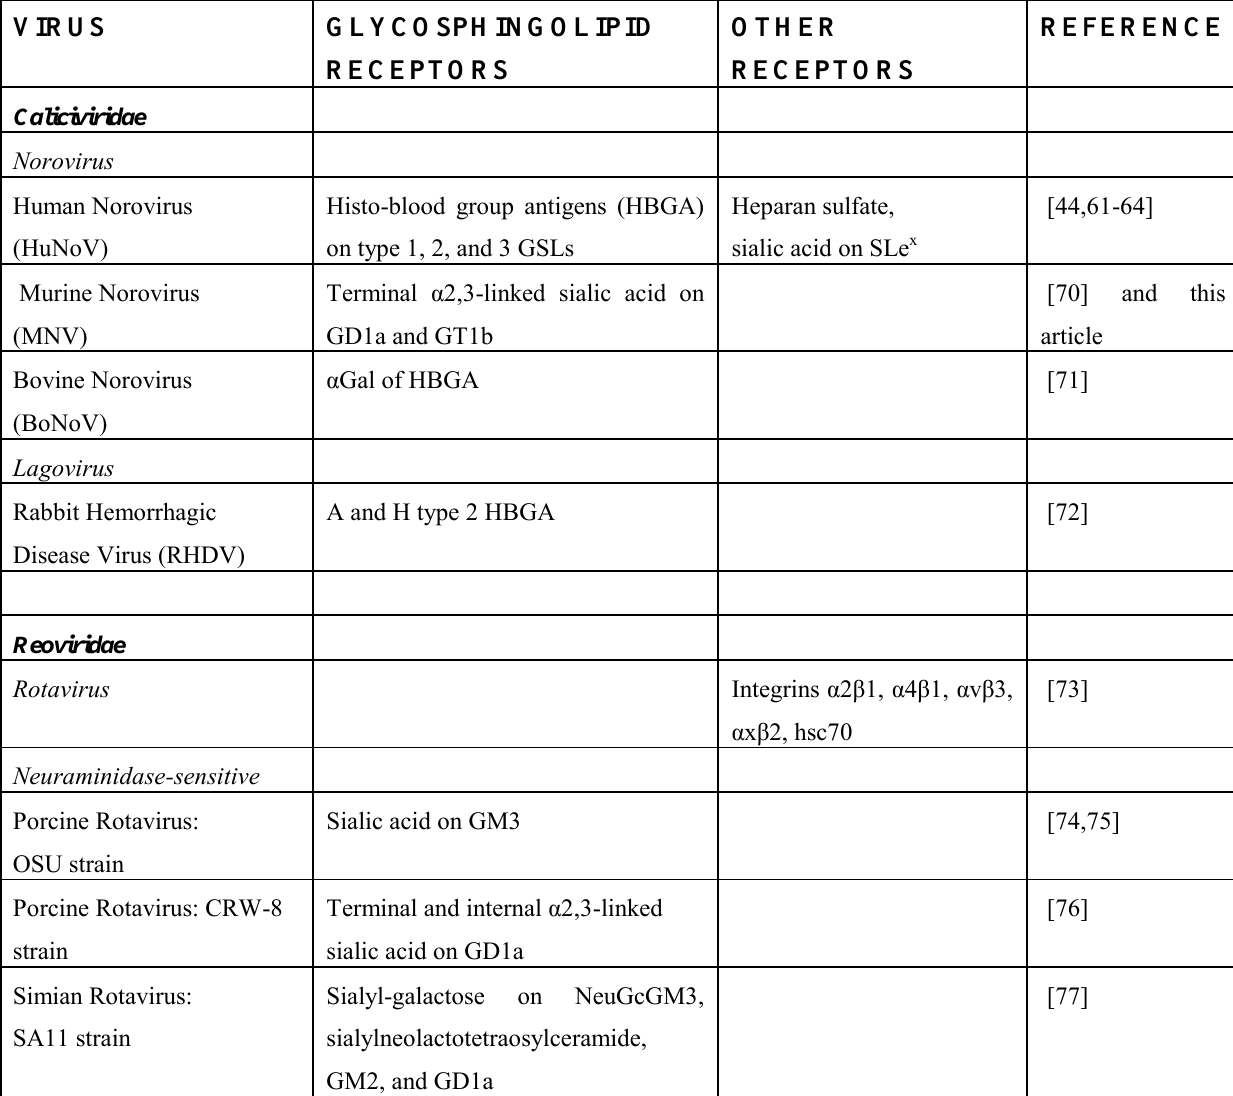
Table 1. Summary of viruses and their glycosphingolipid receptors discussed in the text and respective